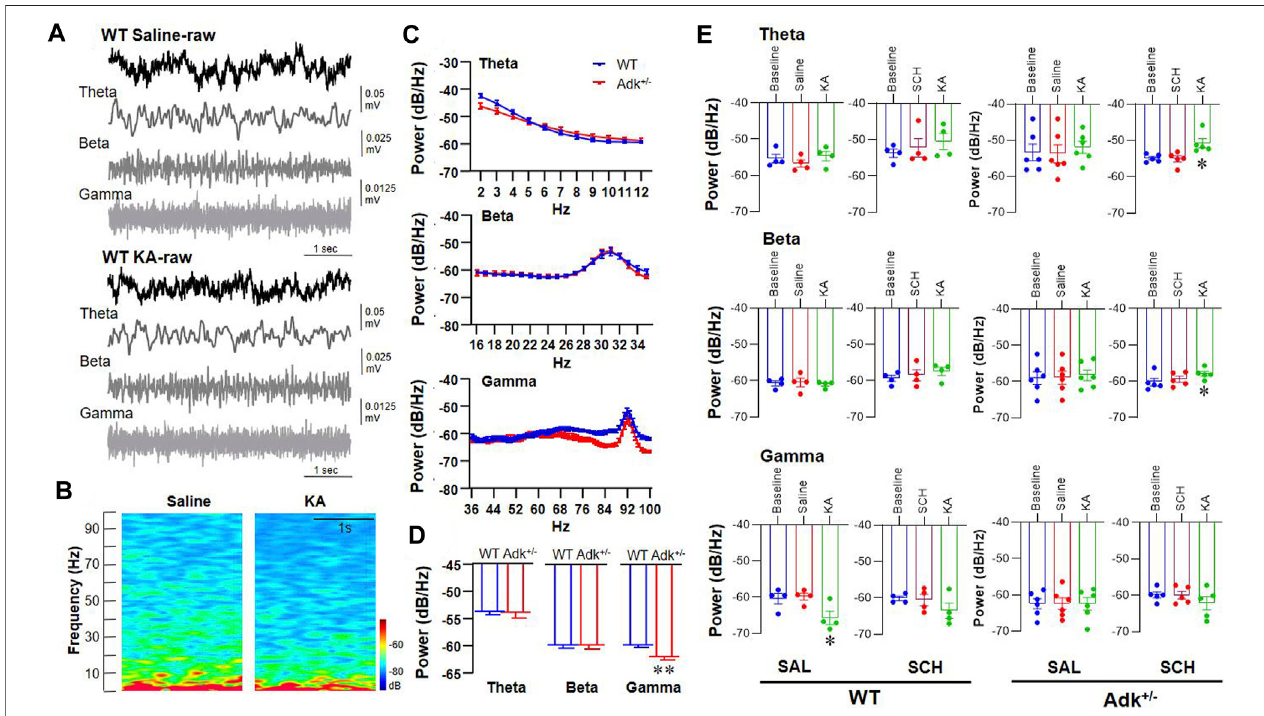
FIGURE 5| Electrophysiological LFP recordingin the NTS of Adk +/- and WT epileptic mice. (A) Typical LFP signals from one WT mouse after saline treatment (top) and subsequent KA injection (bottom). The fi rst row of both upper (WT Saline-raw) and lower (WT KA-raw) panels showing a 5 s of the raw trace; the second to fourth rows in both panels showing a 5 s of fi ltered signals (Theta, Beta, and Gamma, respectively). (B) The power spectrum of the above LFP signals showing a reduced gamma response after KA injection. (C) The averaged power spectrums of LFP from WT and Adk +/- mice, indicating a lower baseline gamma response in Adk +/- mice. (D) The histogram showing a signi fi cant decrease in baseline gamma response in Adk +/- mice. (E) Histograms of the averaged power spectrum of LFP signals showingquantitativechangesintheta(toppanel),beta(middlepanel)andgamma(bottompanel)bandsfromWTandAdk +/- miceafterinjectionsofsalinefollowedKAor SCH followed KA. Data are mean ± SEM. * p < 0.05 vs. corresponding baseline, one-way ANOVA, in (E) ; ** p < 0.01 vs. WT baseline, paired t -test, in (D)